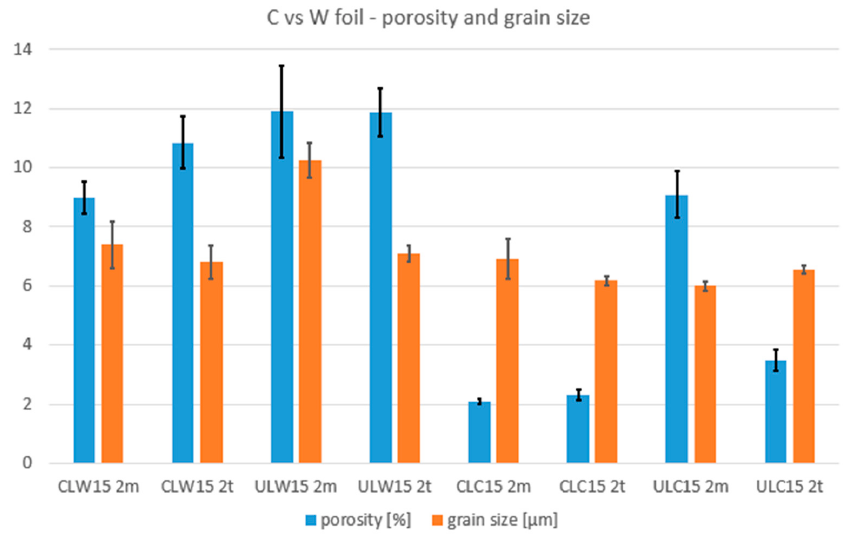
Figure 8. Summary of e ff ects of sintering foil and powder treatment on the porosity volume and grain size of the CLC15, CLW15, ULC15 and ULW15